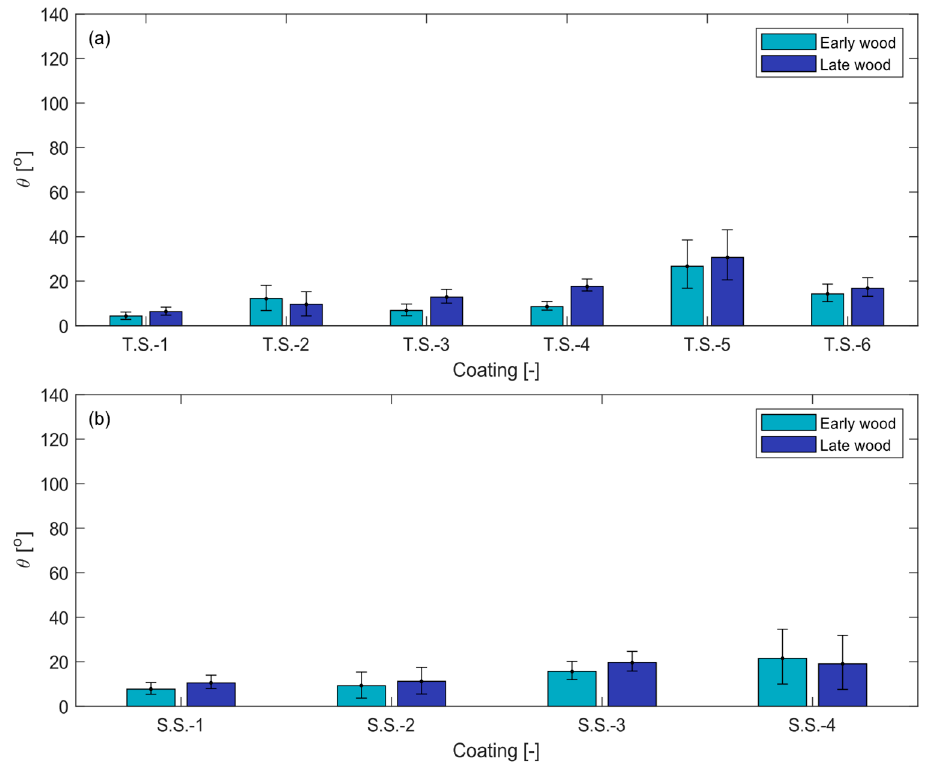
Figure 11. Average coating contact angle at t = 1 min: ( a ) S.S. (semi-transparent stain, solvent-based) and ( b ) T.S. (transparent stain, solvent-based).